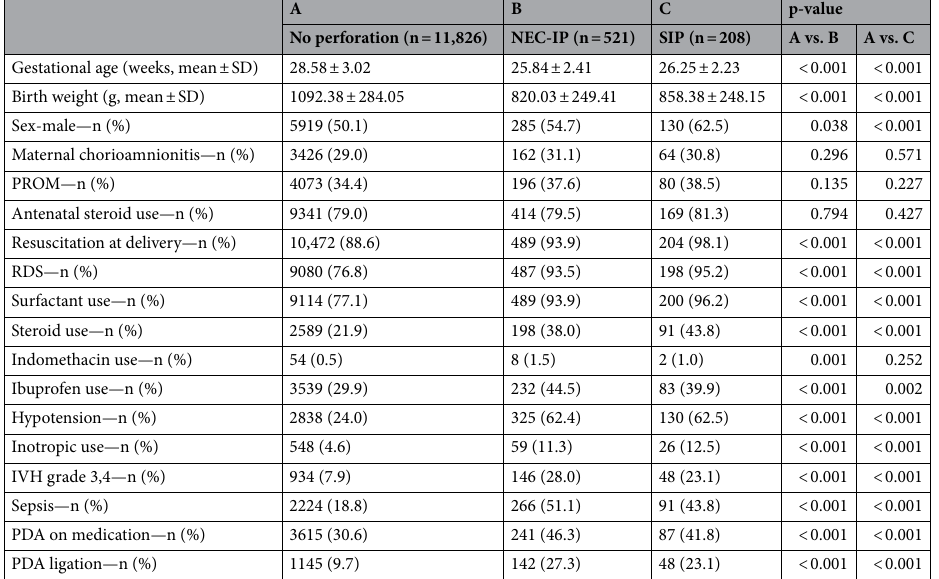
Table 1. Clinical characteristics of the patients. NEC-IP intestinal perforation associated with necrotizing enterocolitis, SIP spontaneous intestinal perforation, SD standard deviation, PROM premature rupture of membranes, RDS respiratory distress syndrome, IVH intraventricular hemorrhage, PDA patent ductus